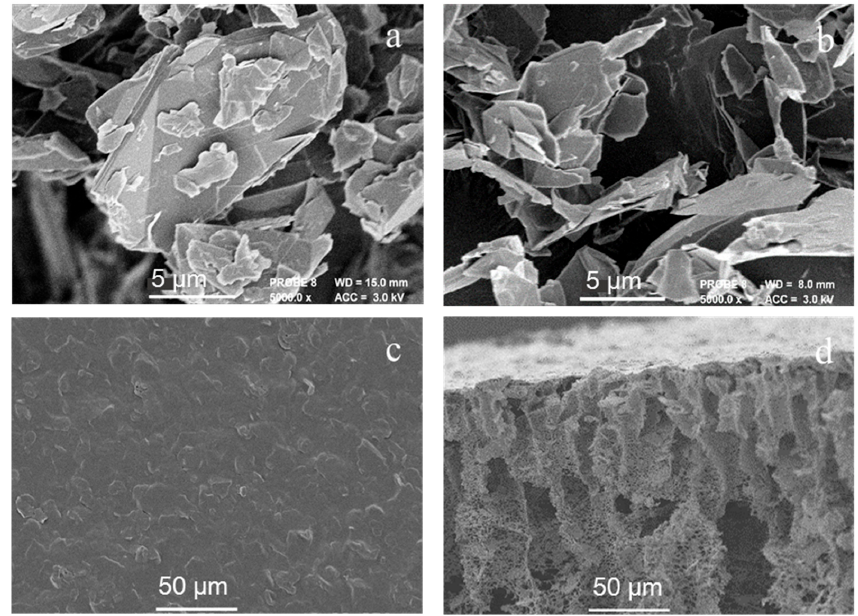
Figure 2. Microstructure of graphite ( a ) and exfoliated graphite ( b ), morphologies of surface ( c ) and cross-section ( d ) of the PANI/EG composite membrane. cross-section ( d ) of the PANI/EG composite